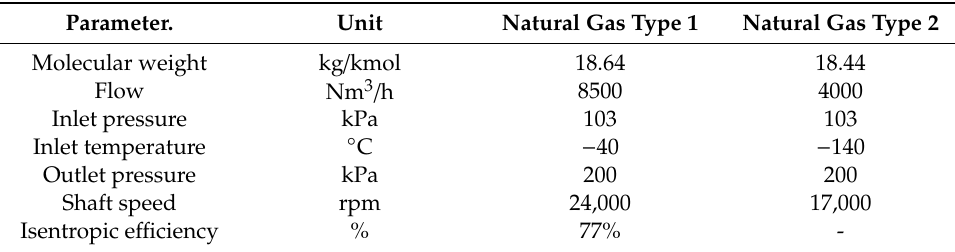
Table 1. Turbo compressor design data [41].